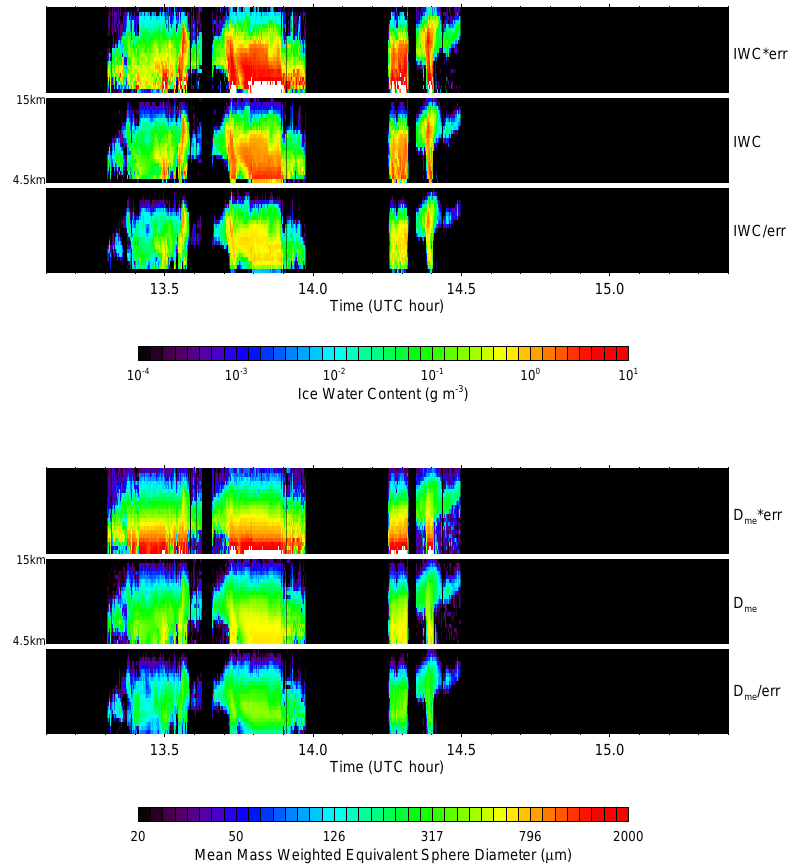
Fig. 20. Ice water content and D me profiles retrieved from nadir Cloud Radar System